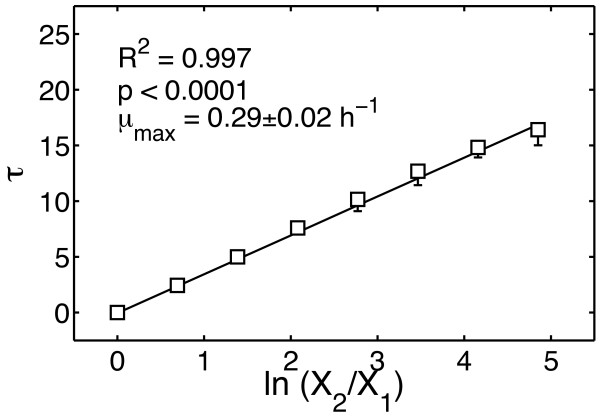
Determining the reproducibility of the lag phase in WT cells. If the mathematical assumption τ = (1/μmax) ln (X2/X1) is correct, then τ as a function of ln (X2/X1) should yield a straight line with a slope of 1/μmax. τ shows a correlation to ln (X2/X1) with an R2 of 0.997 (p < 0.0001) and a μmax of 0.29 ± 0.02 h-1 for WT. The median and range over three independent experiments are plotted as black squares and error bars.